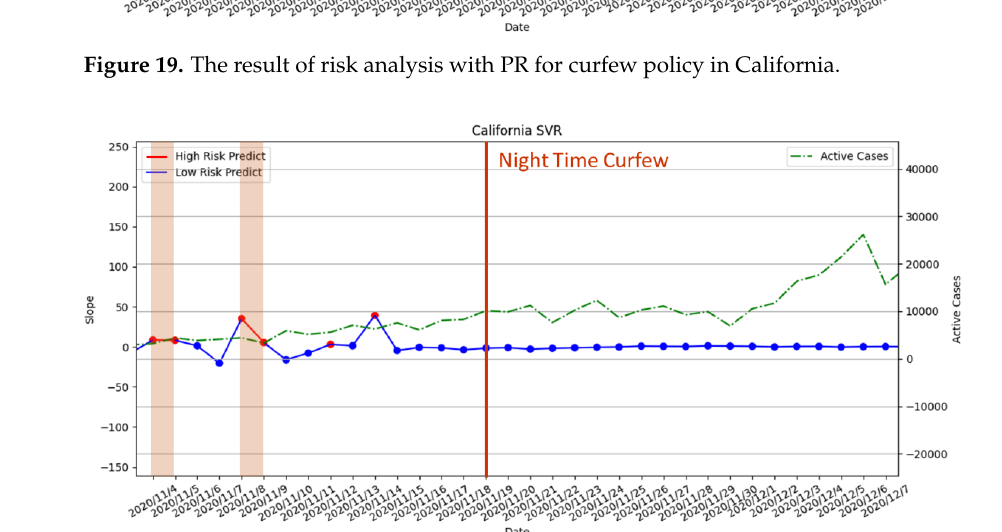
Figure 20. The result of risk analysis with SVR for curfew policy in